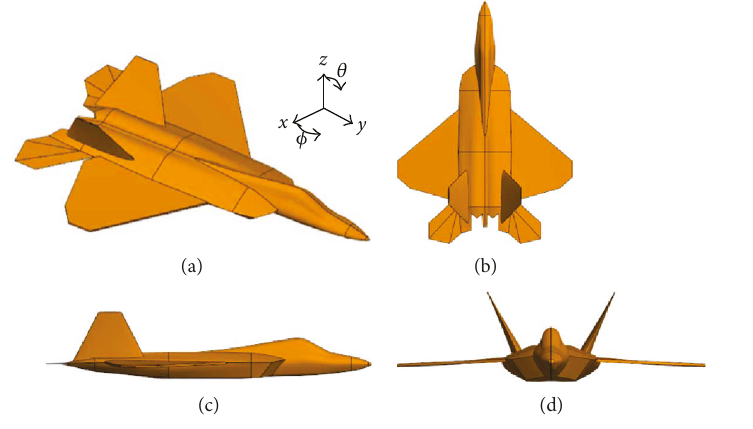
Figure 1: Overview of an aircraft.